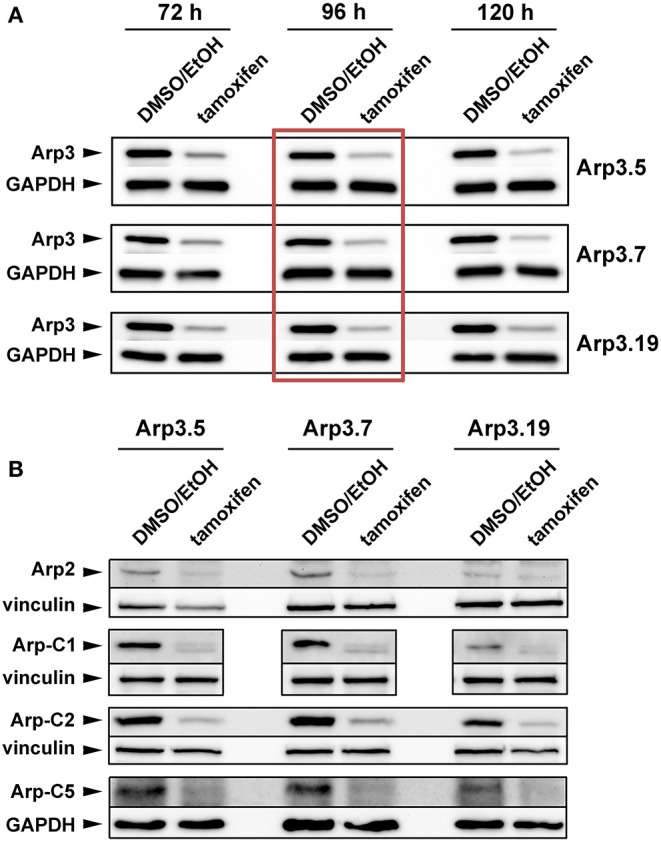
Tamoxifen treatment suppresses expression of Arp2/3 complex subunits. (A,B) Western blot analysis of Arp2/3 complex subunit levels in individual Actr3fl/fl clones after tamoxifen treatment (72, 96, or 120 h) or DMSO/EtOH used as vehicle control. GAPDH and vinculin served as loading controls, dependent on the molecular weight of explored Arp2/3 complex subunit. (A) Although the extent of Arp3 protein decrease correlated with prolonged tamoxifen treatment, a treatment of 96 h (red box) was determined as best compromise between efficient protein run down and cell viability, which was significantly compromised upon 120 h (not shown). The 96 h-time point was thus used for all future experiments. (B) Tamoxifen-induced removal of Arp3 (96 h) concomitantly reduced all additional Arp2/3 complex subunits tested, as indicated.